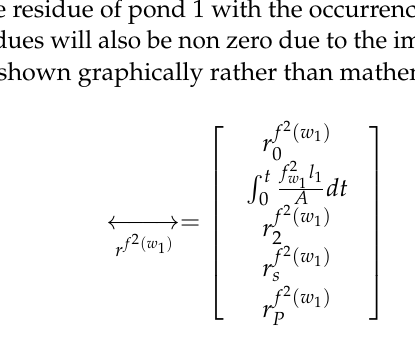
Figure 1. Three-pond hydraulic